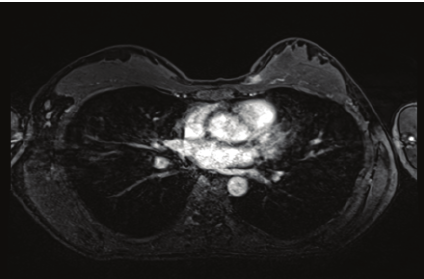
Figure 3: Magnetic resonance imaging (T1-weighted image, fat suppression) showed enhancement of the lesion.